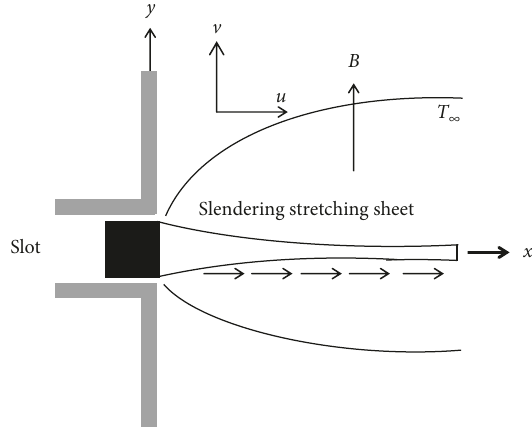
Figure 1: Physical model and coordinate and ambient-side surface resistance, respectively, C w is the concentration at the surface, T is the ambient temperature, ∞ and T w is temperature at the stretching sheet. It is interesting to note here that the heat convection is equal to the heat conduction at the stretching sheet, according to the third part of equation (6). Furthermore, the fourth part of the same equation states that mass convection at the sheet is equal to the rate of change in concentration in the y -direction.